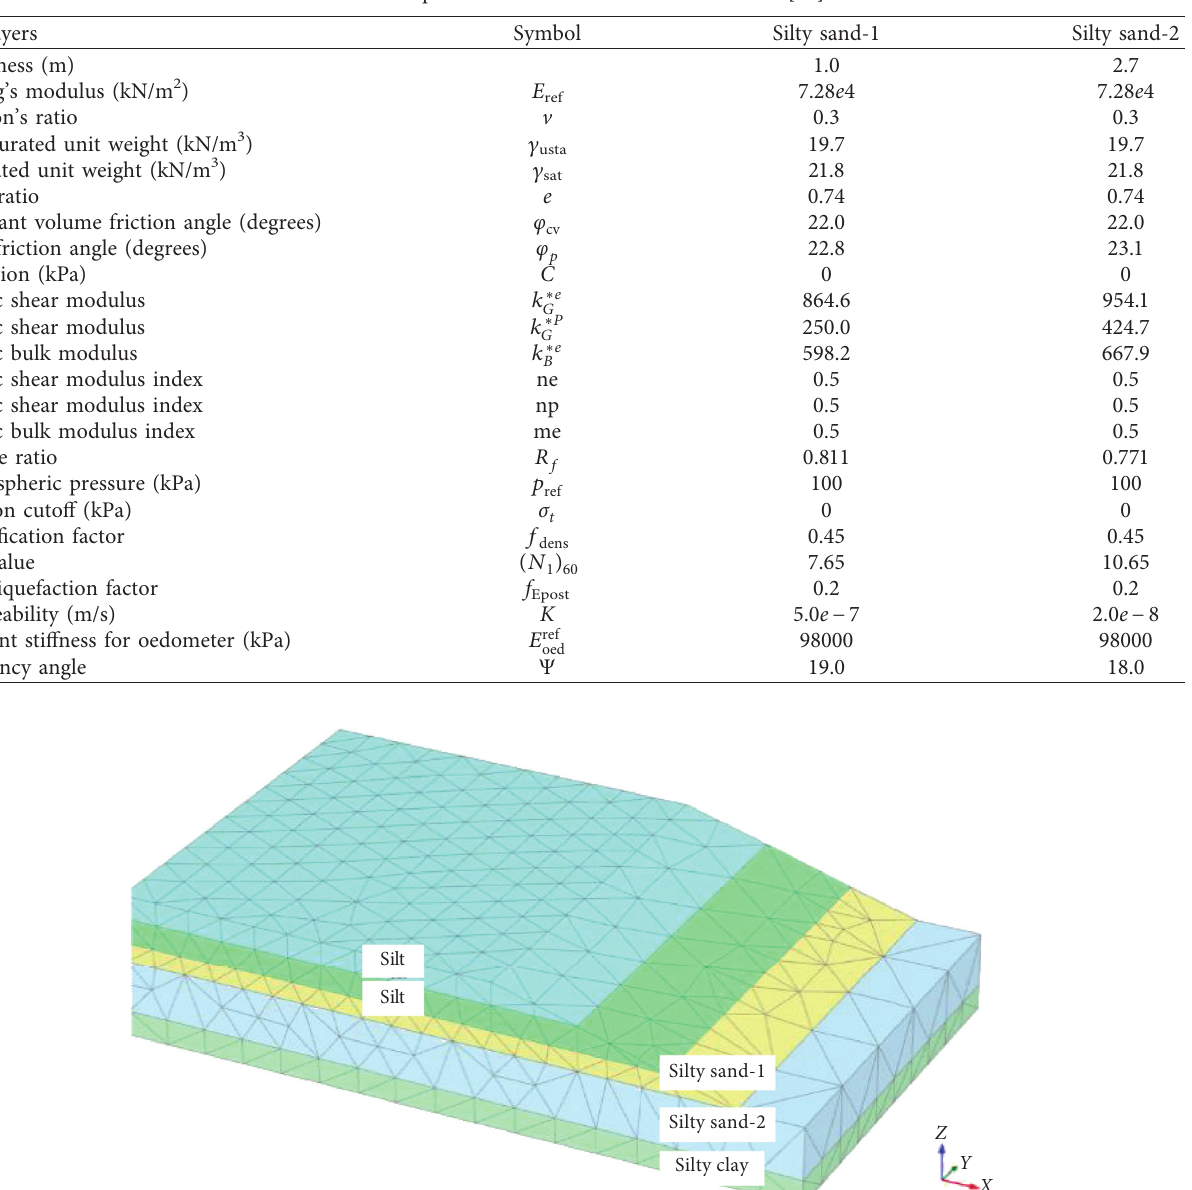
Table 5: Soil parameters of the UBC3D-PLM model [50].